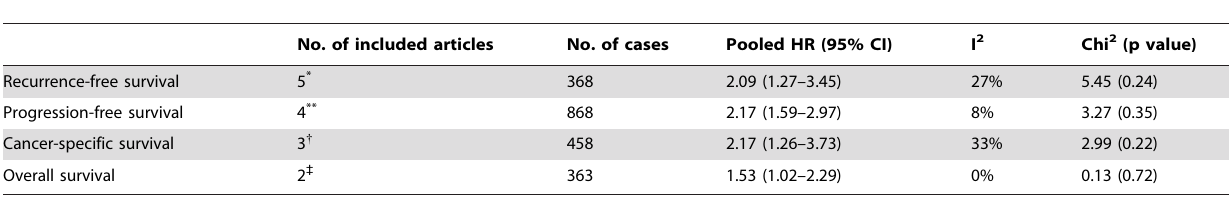
Table 3. Subgroup analysis in non-muscle invasive bladder tumor.